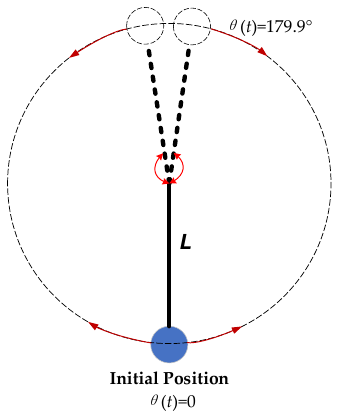
Figure 8. The oscillating nonlinear single pendulum.